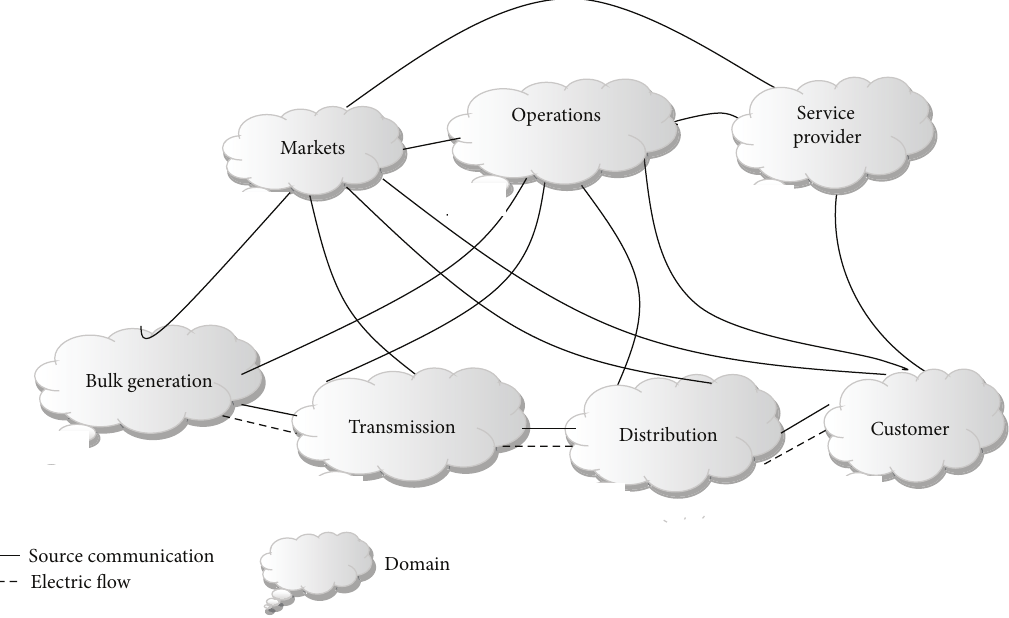
Figure 7: NIST smart grid domains through secure communication flows and electrical flows